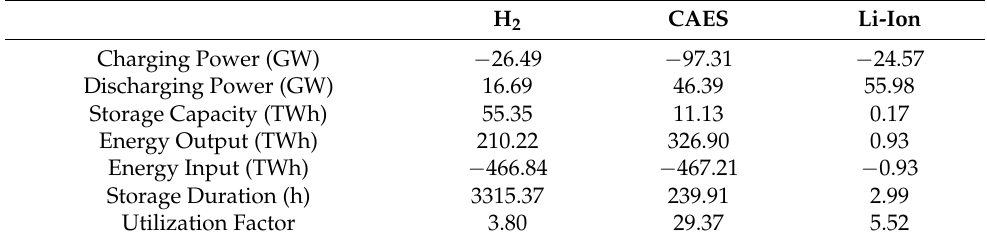
Figure 19. Final profiles obtained for the three different energy stores: hydrogen, CAES, and Li-ion. Table 5. Technical specifications of the three types of energy store in the optimum system configuration.